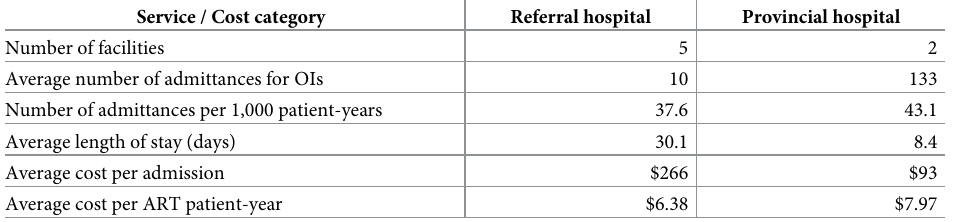
Table 9. Average utilization and unit costs of inpatient care for opportunistic infections, average by type of